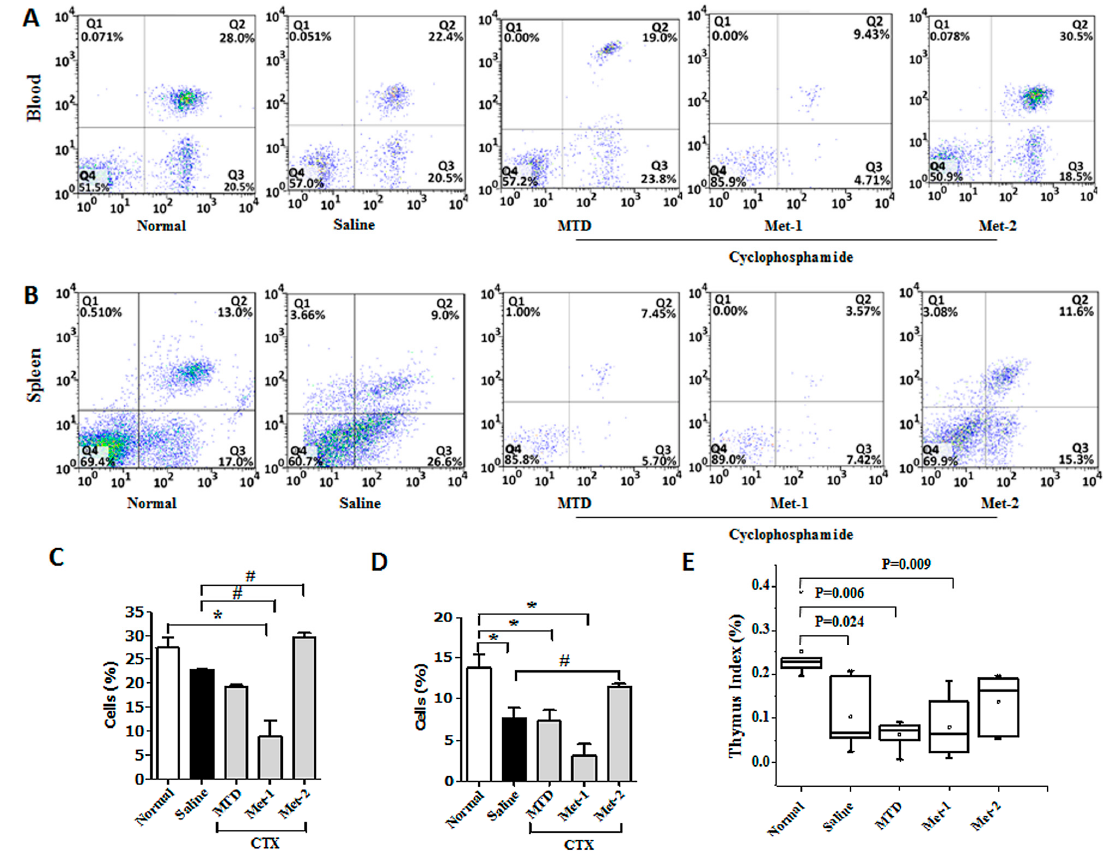
Figure 4. CD3 + / CD4 + T cells in blood ( A , C ) and spleen ( B , D ) from each group at the end of the observation period were measured by flow cytometry analysis. Fresh blood was collected in EDTA tubes and flow cytometry analysis was performed as described previously. ( E ) Thymus Index. Thymuses were collected and Thymus index was calculated. “*” versus normal group and “#” versus saline group. * p < 0.05, # p < 0.05.